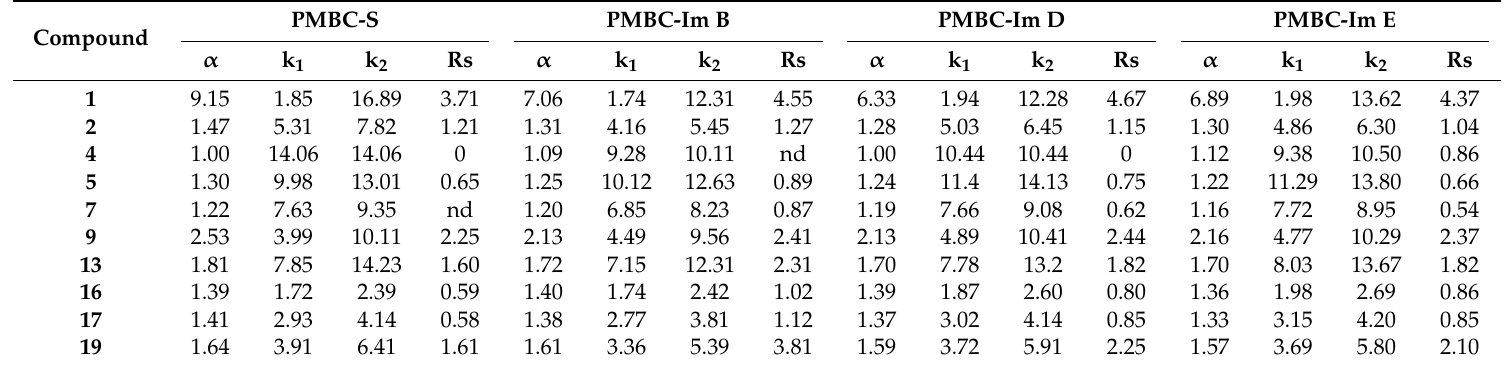
Table 2. Chromatographic results of the enantioselective separations of selected racemic compounds on photochemically immobilized PMBC-Im CSPs: influence